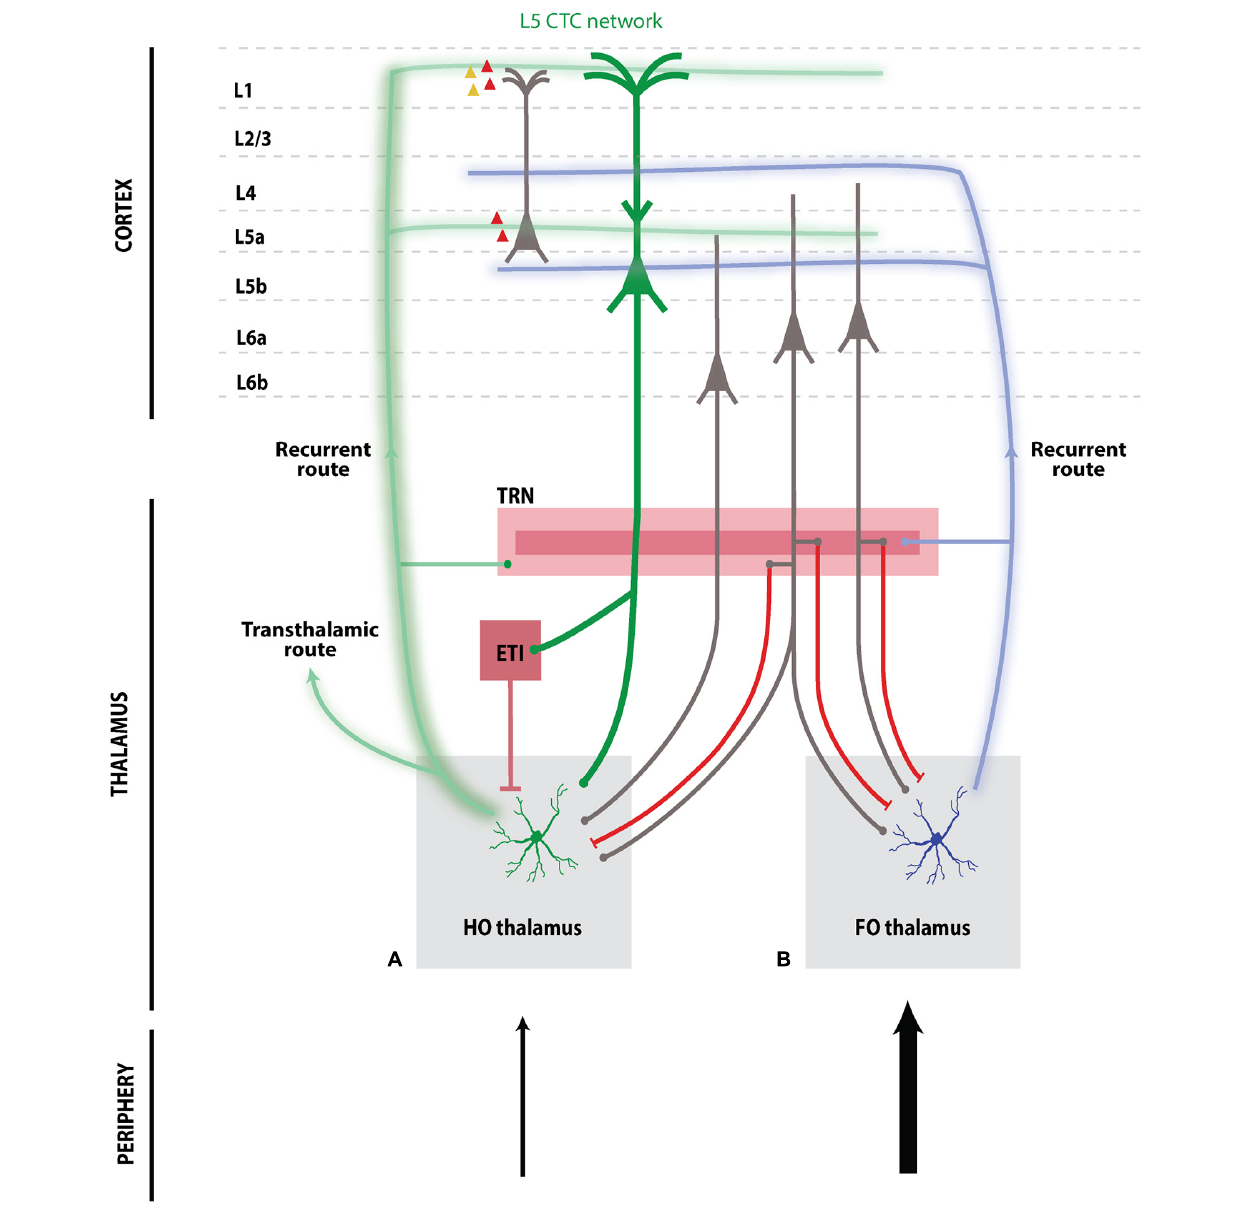
FIGURE 1 | Schematic of higher-order (A) and first-order (B) cortico-thalamo-cortical networks. L5 thick-tufted pyramidal cells in L5B send projections to HO thalamic nuclei and to additional subcortical targets including extrathalamic inhibitory (ETI) sources, e.g., the ZI and APT, which exert strong inhibition on HO nuclei. HO thalamus (A) sends TC projections across transthalamic routes to other cortical regions, or forms a recurrent route back to the same cortical region targeting L5A and upper layers. HO TC projections target excitatory pyramidal cells, as well as PV (red) and 5HT3-positive inhibitory (yellow) interneurons, although there are modality-specific variations (e.g., associative thalamus). In contrast, FO thalamus (B) sends recurrent TC projections to cortical layers L5B and L4. L6 corticothalamic cell subpopulations display distinct connectivity with thalamic nuclei: Upper L6A cells specifically target FO thalamus, while lower L6A cells target both FO and HO thalamus; both populations send collaterals to inhibitory TRN. L6B cells specifically target HO thalamus but do not send collaterals to TRN. Both HO and FO nuclei engage intrathalamic inhibitory feedback loops via excitatory projections to TRN. Outer “shell” TRN sends inhibitory projections to HO thalamus while inner “core” TRN sends inhibitory projections to FO